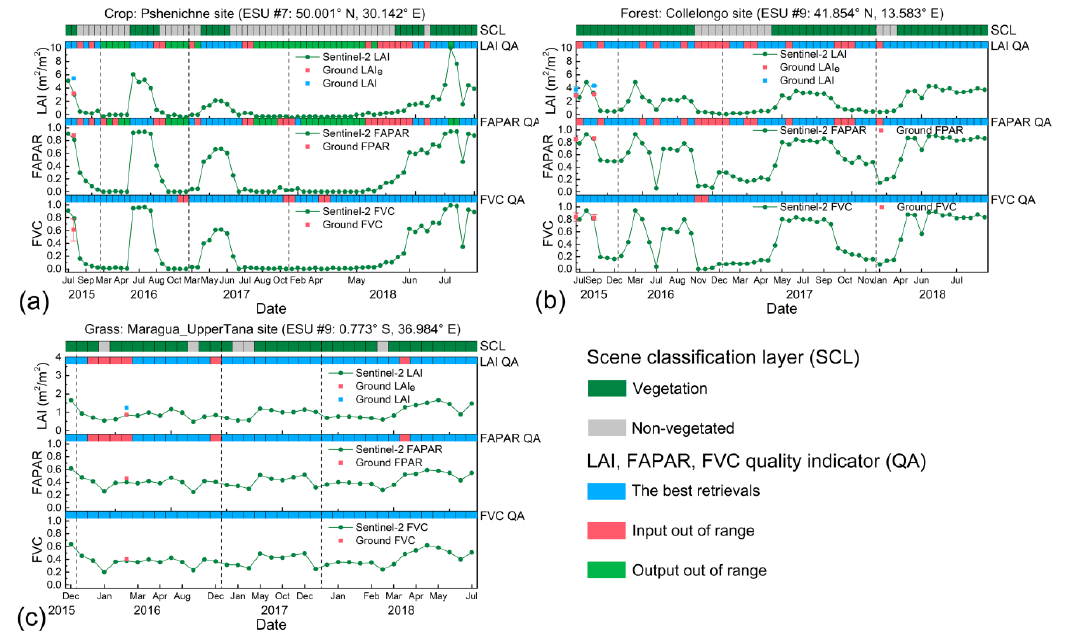
Figure 6. The temporal trajectory of Sentinel-2 LAI, FAPAR, and FVC estimates from July 2015 to July 2018 at the ( a ) crop site, ( b ) forest site, and ( c ) grass site, respectively. The square point indicates the value of the ground ESU. The scene classification layer (SCL) shown at the top of each panel was extracted from Sentinel-2 surface reflectance products. The quality indicator (QA) was also displayed together with the biophysical variable for each observation date.